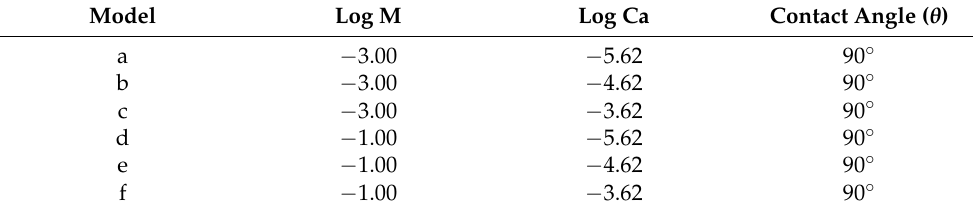
Table 3. Capillary number and viscosity ratio used in the simulation.